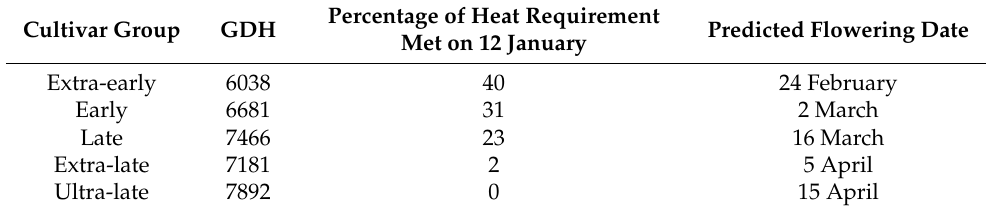
Table 2. Heat requirements (GDH) needed to flower, percentages of heat requirements met on 12 January (frost date) and flowering date for each cultivar